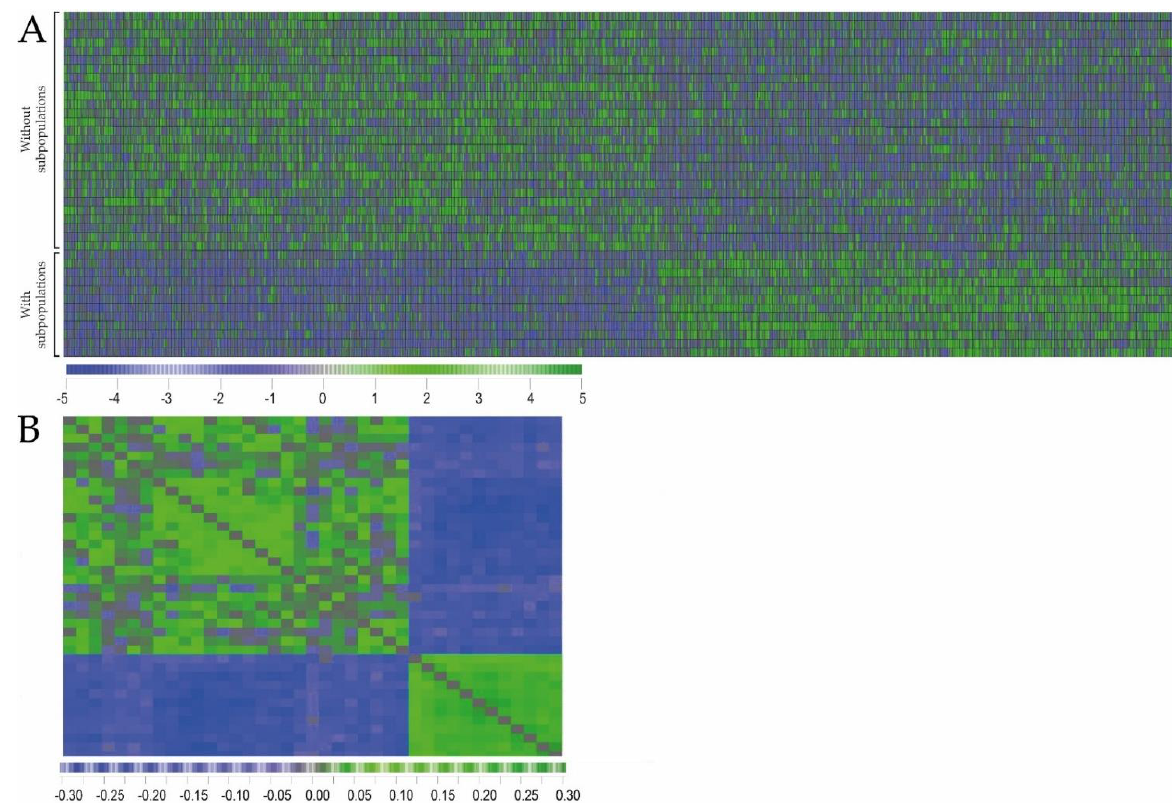
Figure 2. Comparison of global gene expression profiles and gene ontology for primary human AML cells with and without clonal heterogeneity based on the analysis of PI3K-Akt-mTOR activation. Global gene expression profiles (GEP) were available for 39 unselected AML patients included in the study, 12 samples were derived from patients showing dual cell populations and 27 leukemic cell populations did not show dual cell populations. ( A ) A feature subset selection (FSS) was performed to identify the most discriminative genes between the two groups, and 1209 genes were identified ( p - value <0.05). These genes were used in a hierarchical clustering model (Pearson’s correlation distance measure with complete linkage) demonstrating a highly discriminative expression pattern for the groups with and without subclones. ( B ) A correlation visualization with distance matrix displays the pairwise correlation between the 39 patients. Blue and green colors highlight the negative and positive correlation between samples. The genes found differently expressed were thereafter used to identify gene ontology terms (using the David Database for Gene Ontology) that were overrepresented among the genes differently expressed. A more detailed version is shown in Figure S3.